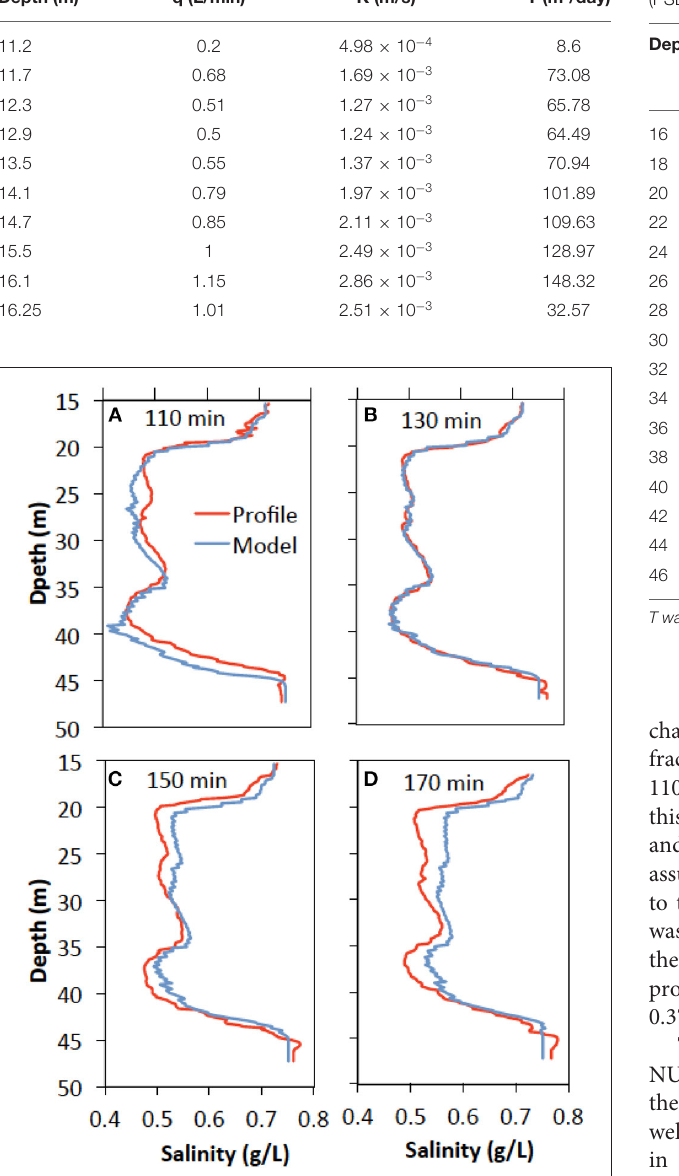
TABLE 1 | Flow strength and concentration obtained from BORE II modeling and estimated transmissivities for the Ajatshatru Residential Hall (ARH) well. Depth (m)